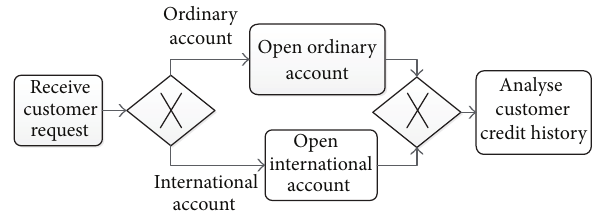
Figure11:TheresultingsubgraphoftheprocessmodelinFigure 1(c) after executing the query in Figure